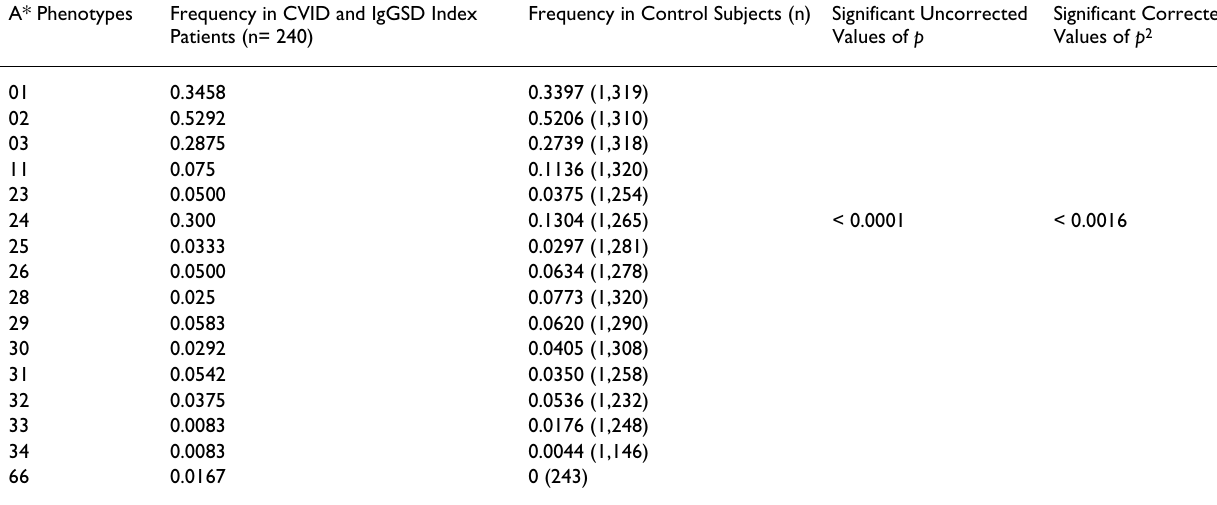
Table 2: Phenotype Frequencies of HLA-A Alleles in Alabama Subjects.